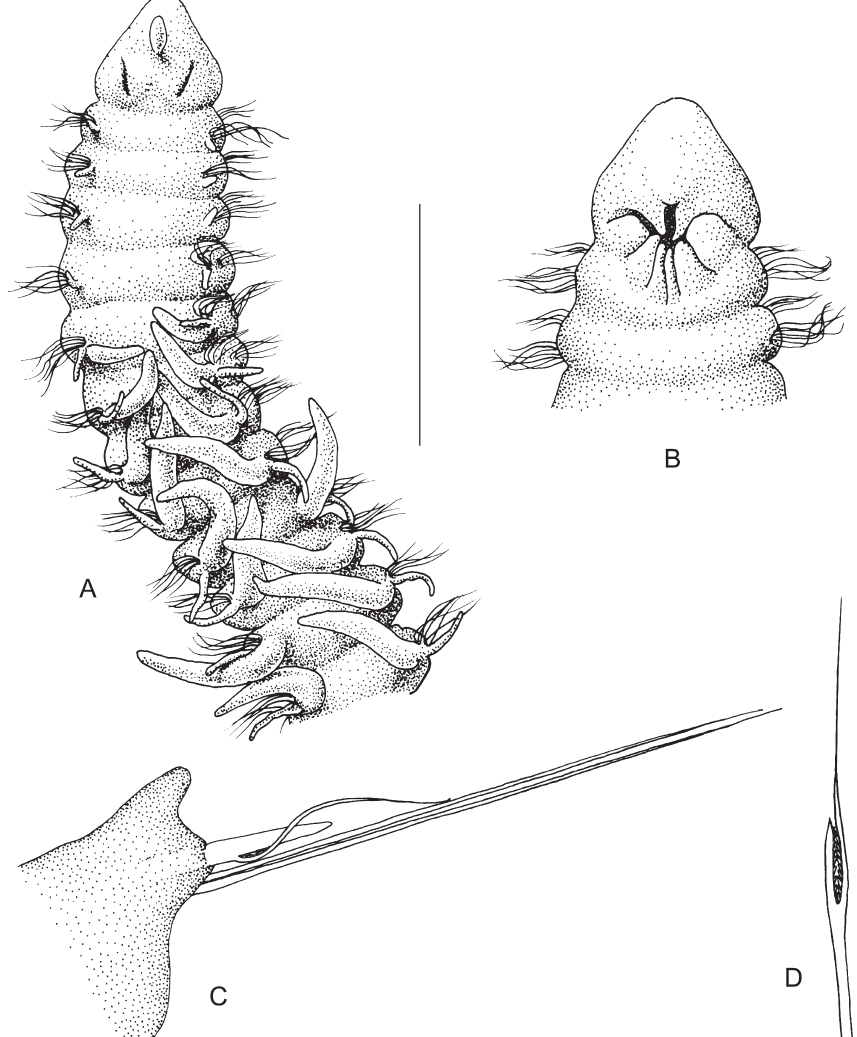
Fig . 6. – Cirrophorus branchiatus : A, anterior region, dorsal view; b, anterior region, ventral view; c, notopodium, chaetiger 21; D, lyriform dorsal modified chaeta, chaetiger 5. Scale bar: A 560 µ m; b 450 µ m; c 70 µ m; D 50 µ